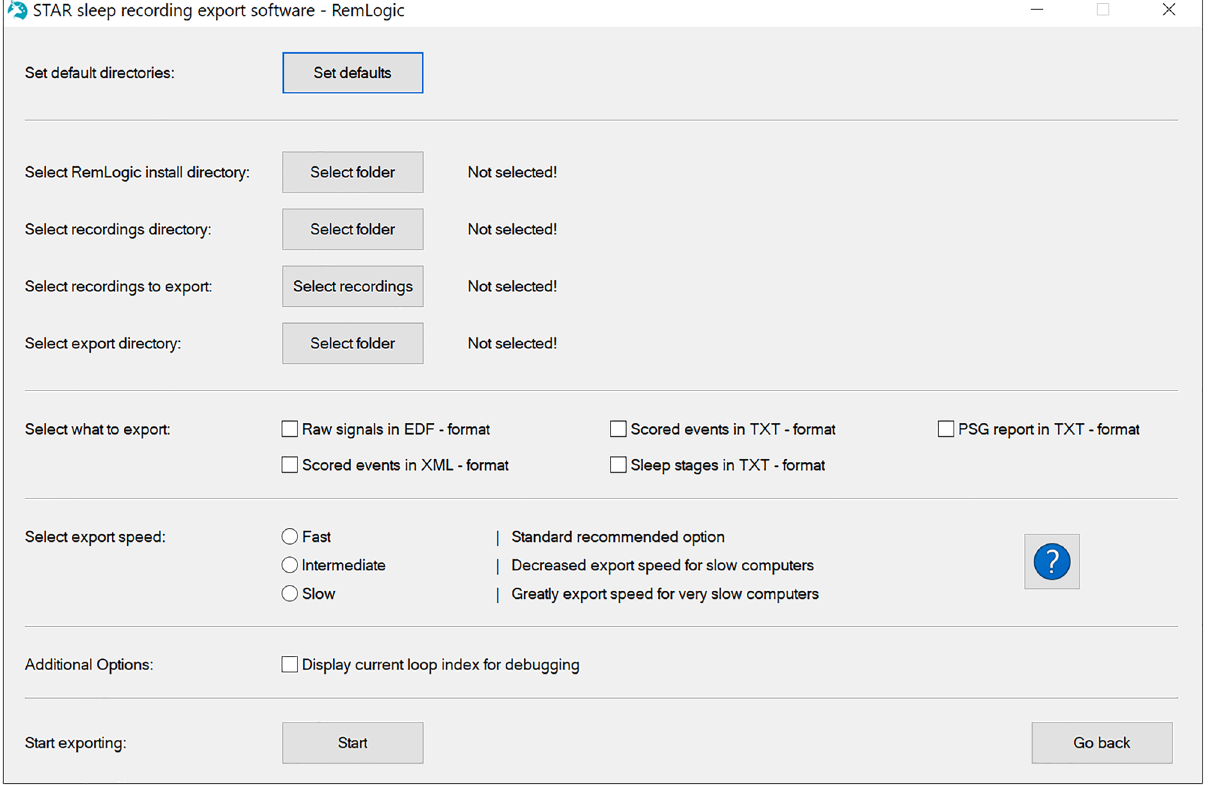
Figure 2. Export selection window for RemLogic recordings. Noxturnal, Profusion PSG and Sleepware G3 have the same main layout and